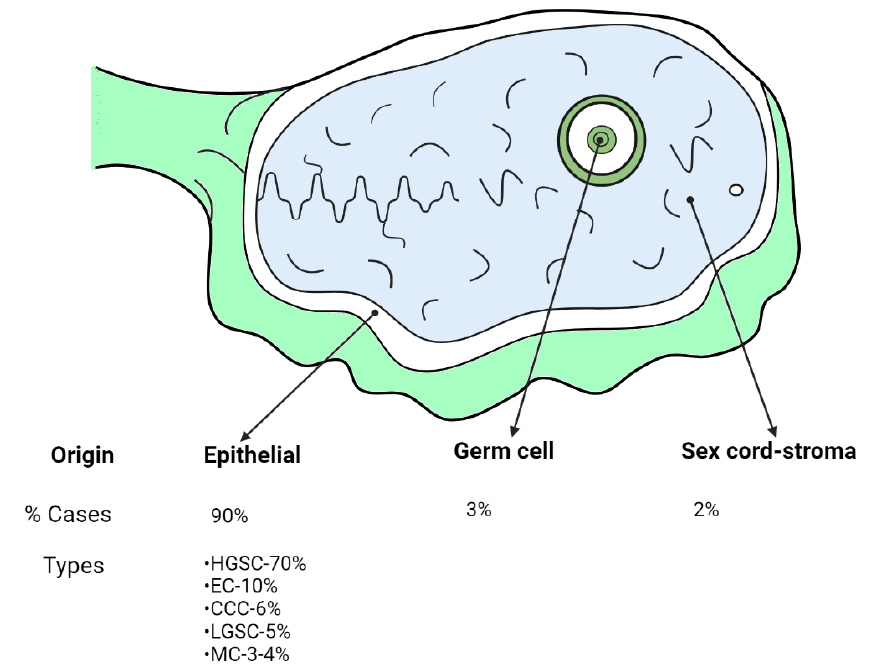
Figure 1. The different origins of ovarian tumors, specifically the types of Epithelial Ovarian Carci- noma (EOC), created by Biorender.com (accessed on 26 August 2022). High-grade serous carcinoma (HGSC); Low-grade serous carcinoma (LGSC); Endometrioid carcinoma (EC); Clear cell carcinoma (CCC); Mucinous carcinoma (MC).